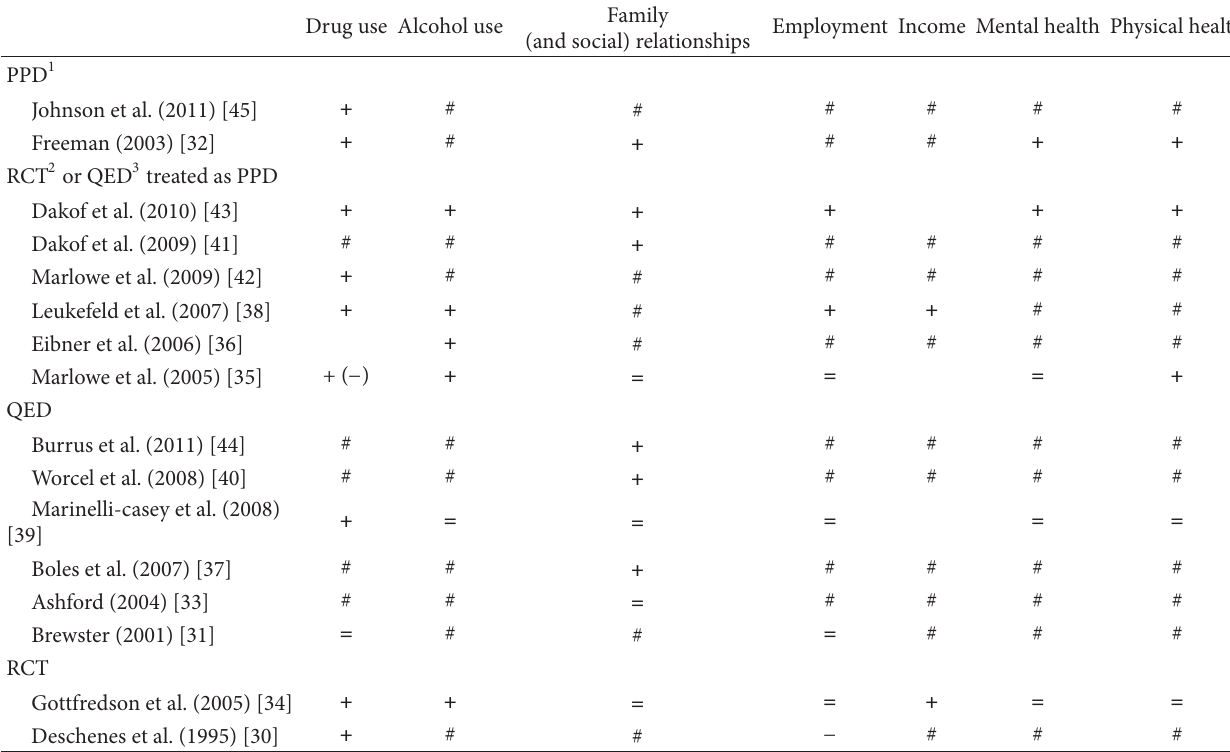
A “+” indicates a signi�cant difference in favor of the DTC, a “ ∗ difference between the DTC and the control group, and “#” indicates that the outcome variable was not reported. 1 non-controlled pre-post design. 2 randomized controlled